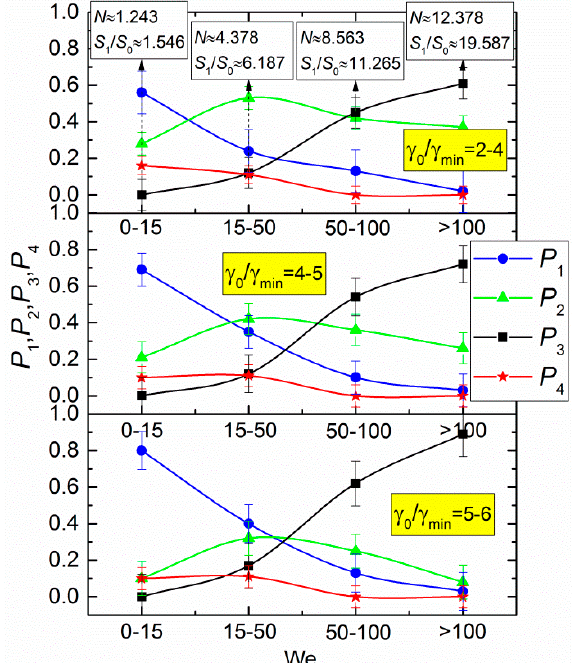
Figure 5. Frequency of each of four droplet interaction modes ( P 1 —coalescence, P 2 —separation, P 3 —disruption, P 4 —bounce) when varying relative droplet concentration. The scale of relative concentration (m 3 of liquid droplets in 1 m 3 of gas) before droplet interaction was γ 0 = 0.5 L/m 3 .